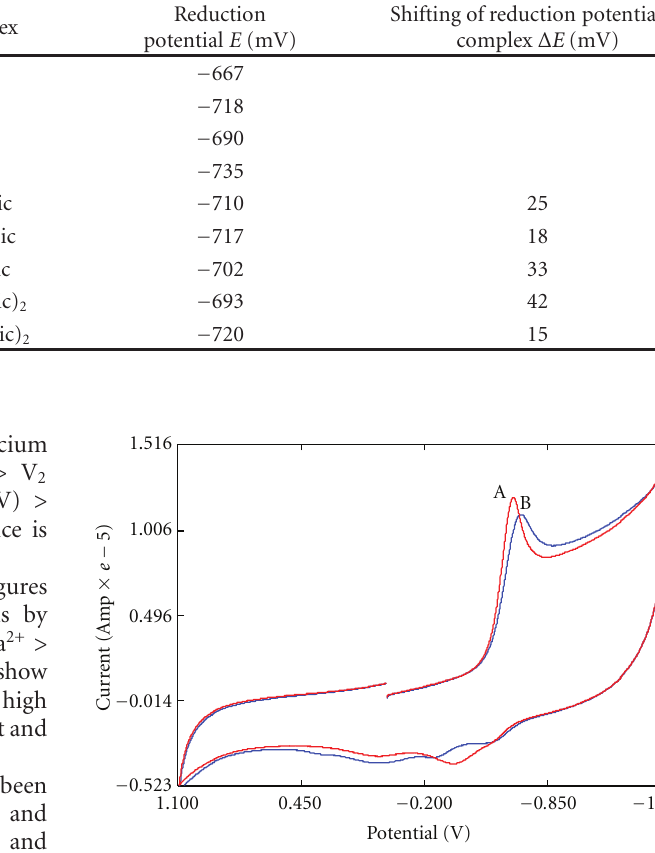
Figure 2: Cyclic voltammograms: (A) 1,5-dichloroanthraquinone ( − 667mV), (B) ionophore V 1 ( − 718mV). Scan rate 100(mV/s), and switching potential from 1100mV to −